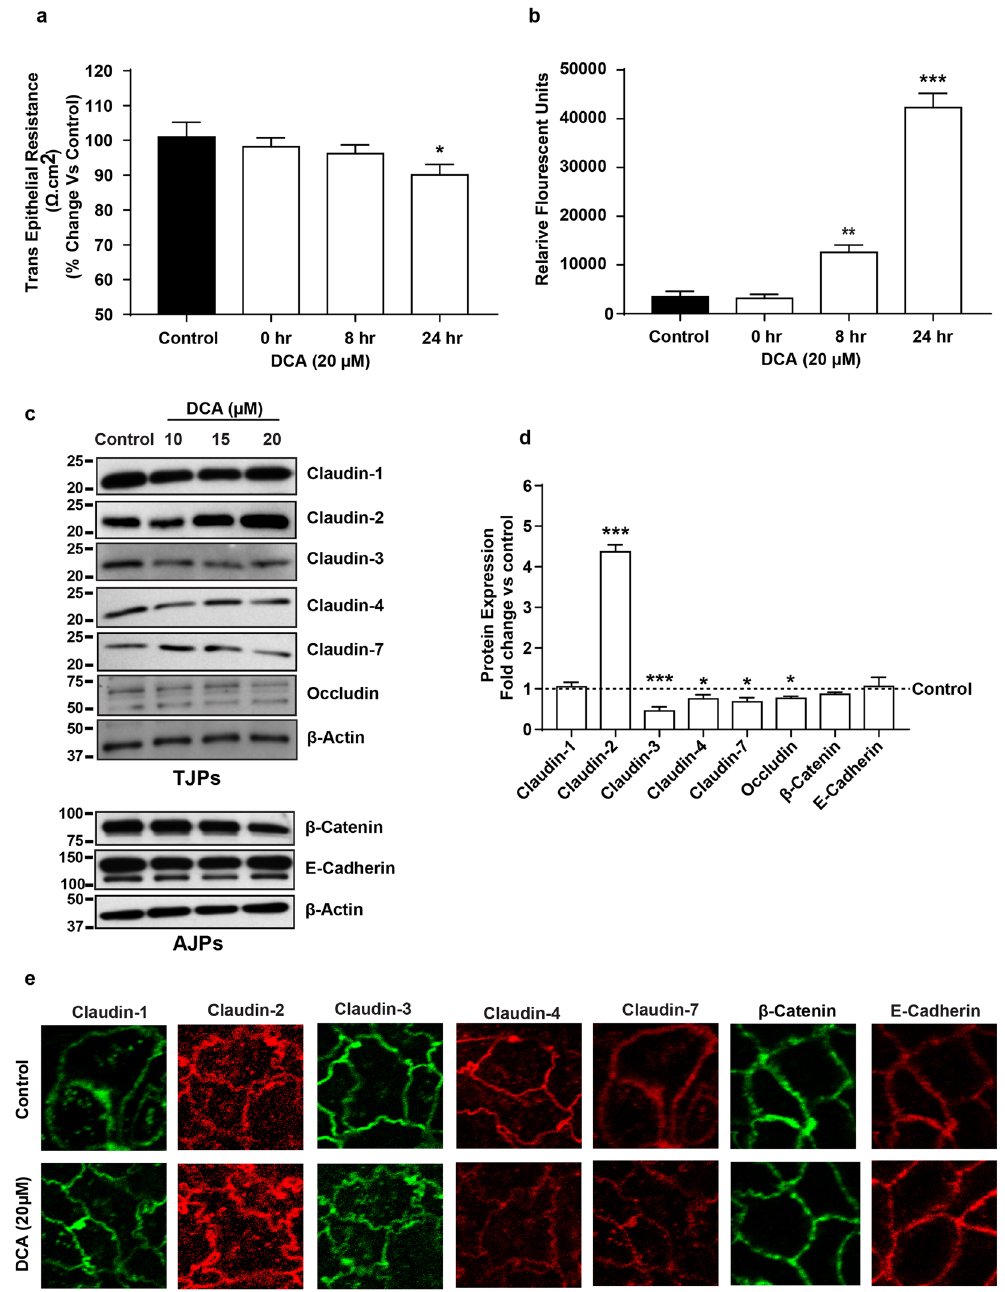
Figure 5. Exposure of intestinal epithelial cell (IEC) to Bile acid (DCA) modulates tight junction composition and barrier function similar to the HFD-induced tight junction restructuring in gut epithelium. Polarized monolayer of Caco-2 cells was subjected to DCA (20 µ M)-treatment (in complete culture medium) for different time-points . ( a ) Effect of DCA-treatment upon TER across the cell monolayer; ( b ) Apico-basal paracellular permeability in control or DCA-treated cells as described in “materials and methods”. ( c ) Immunoblots analysis of total cell lysate from control and DCA treated cells by using antigen-specific antibodies; ( d ) Quantitative analysis of the antigen specific band intensity from immunoblot analysis; ( e ) Representative confocal immunoflurescent imaging to determine cellular localization of cell-adhesion proteins (TJPs and AJPs) in control and DCA-treated cells. Values are presented as mean ± SEM. *** P ≤ 0.001, ** P ≤ 0.01 and * P ≤ 0.05 compared to